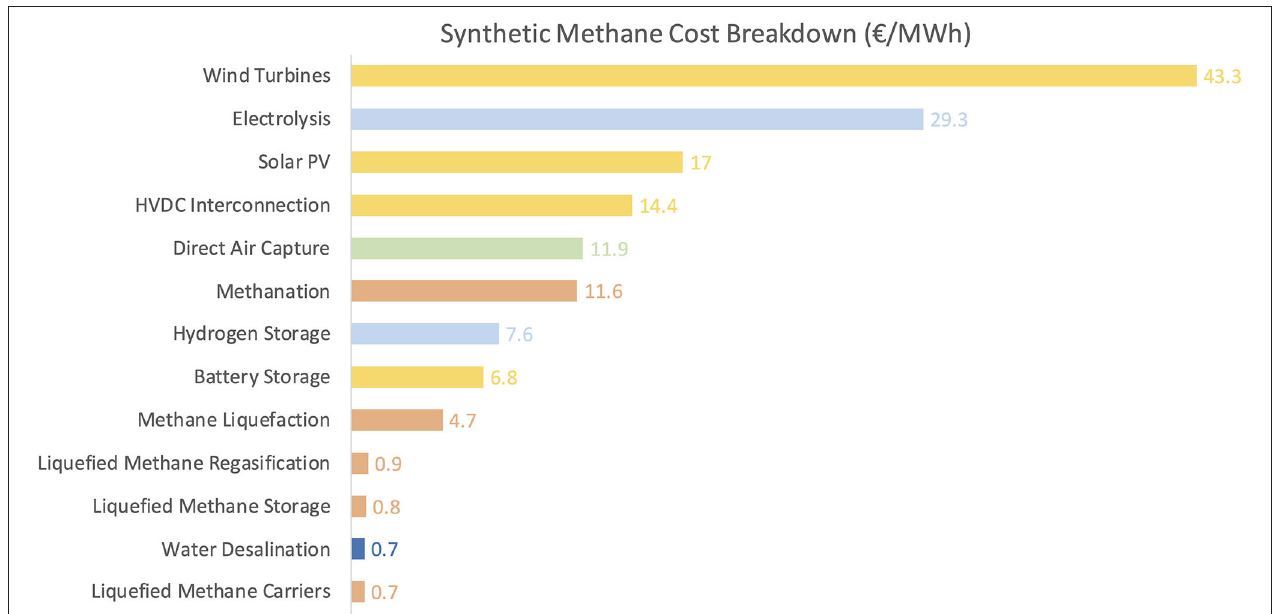
FIGURE 6 | Breakdown of synthetic methane cost at destination for reference scenario. All contributions roughly sum to 149.7 e /MWh